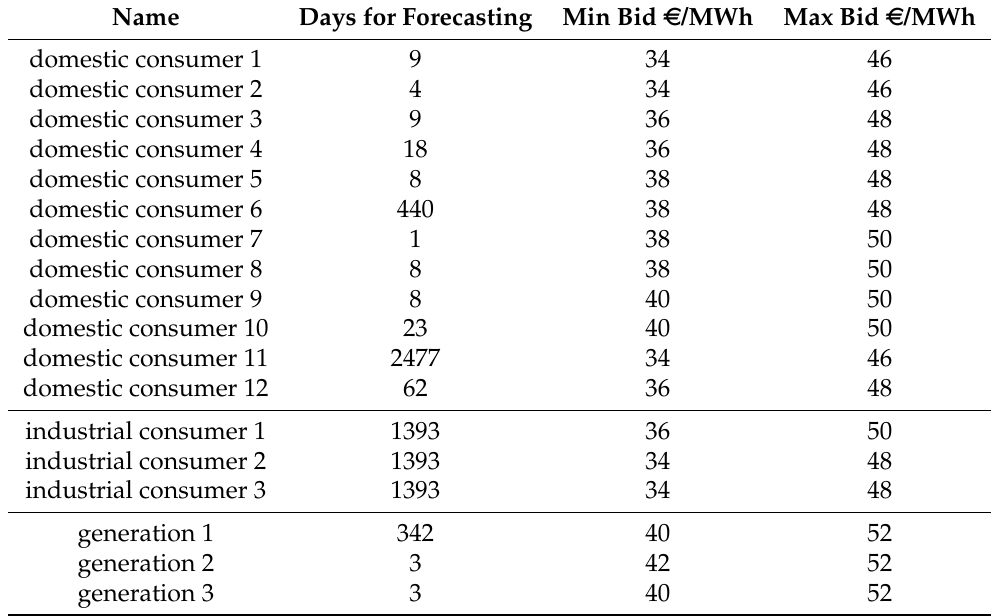
Table 1. Case Study participant’s profiles.